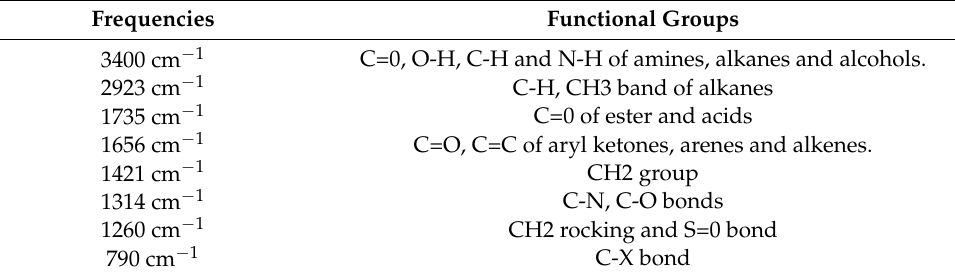
Table 1. FTIR spectral data of n -hexane extract of fruit of Rosa webbiana .